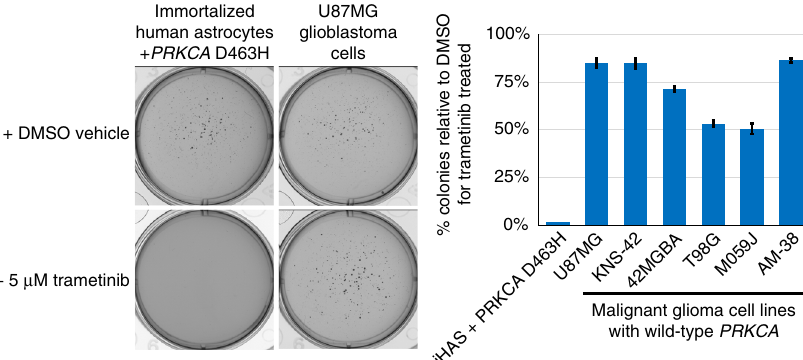
Fig. 4 MEK inhibition is suf fi cient to block the oncogenic effects of mutant PRKCA . Colony formation in soft agar was assessed for immortalized human astrocytes transduced with D463H mutant PRKCA alongside multiple malignant glioma cell lines, all of which harbor wildtype PRKCA alleles. DMSO vehicle or 5 μ M trametinib was added to the top agar layer during casting. Images of representative wells (left) and quantitation of the percent reduction in colony number of trametinib treated wells relative to DMSO-treated wells (right) are shown. Error bars represent standard deviation from the mean of six replicates derived from two independent experiments performed in